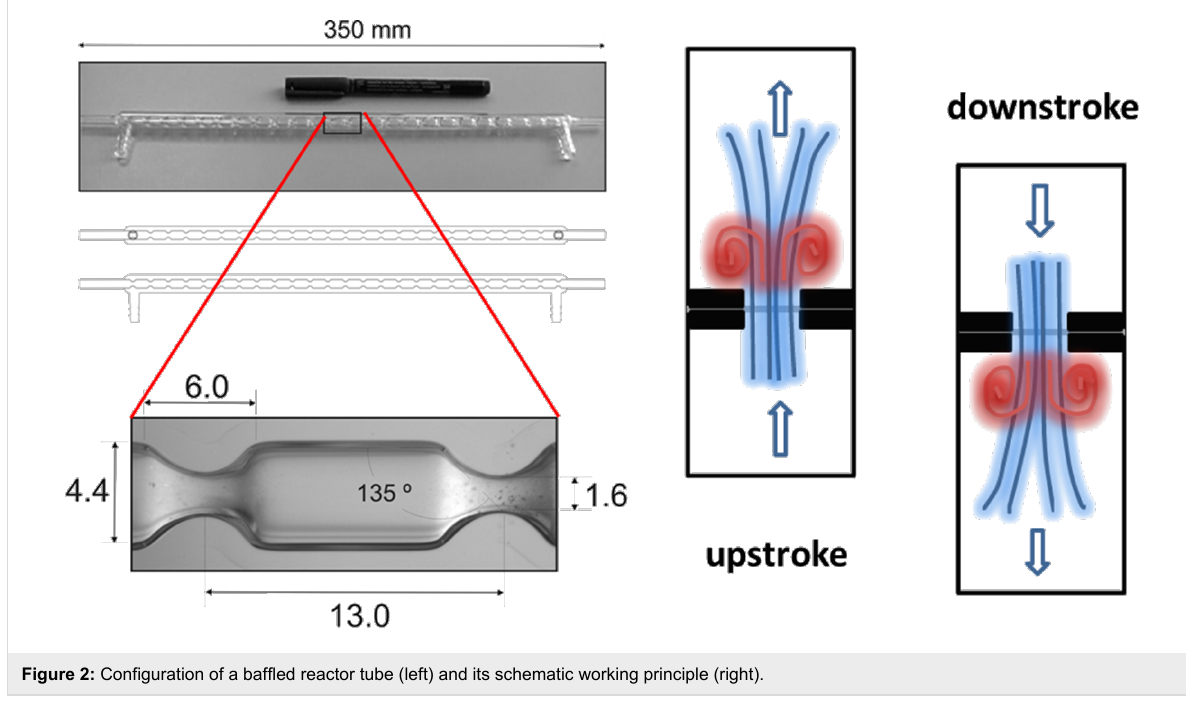
Figure 2: Configuration of a baffled reactor tube (left) and its schematic working principle (right).